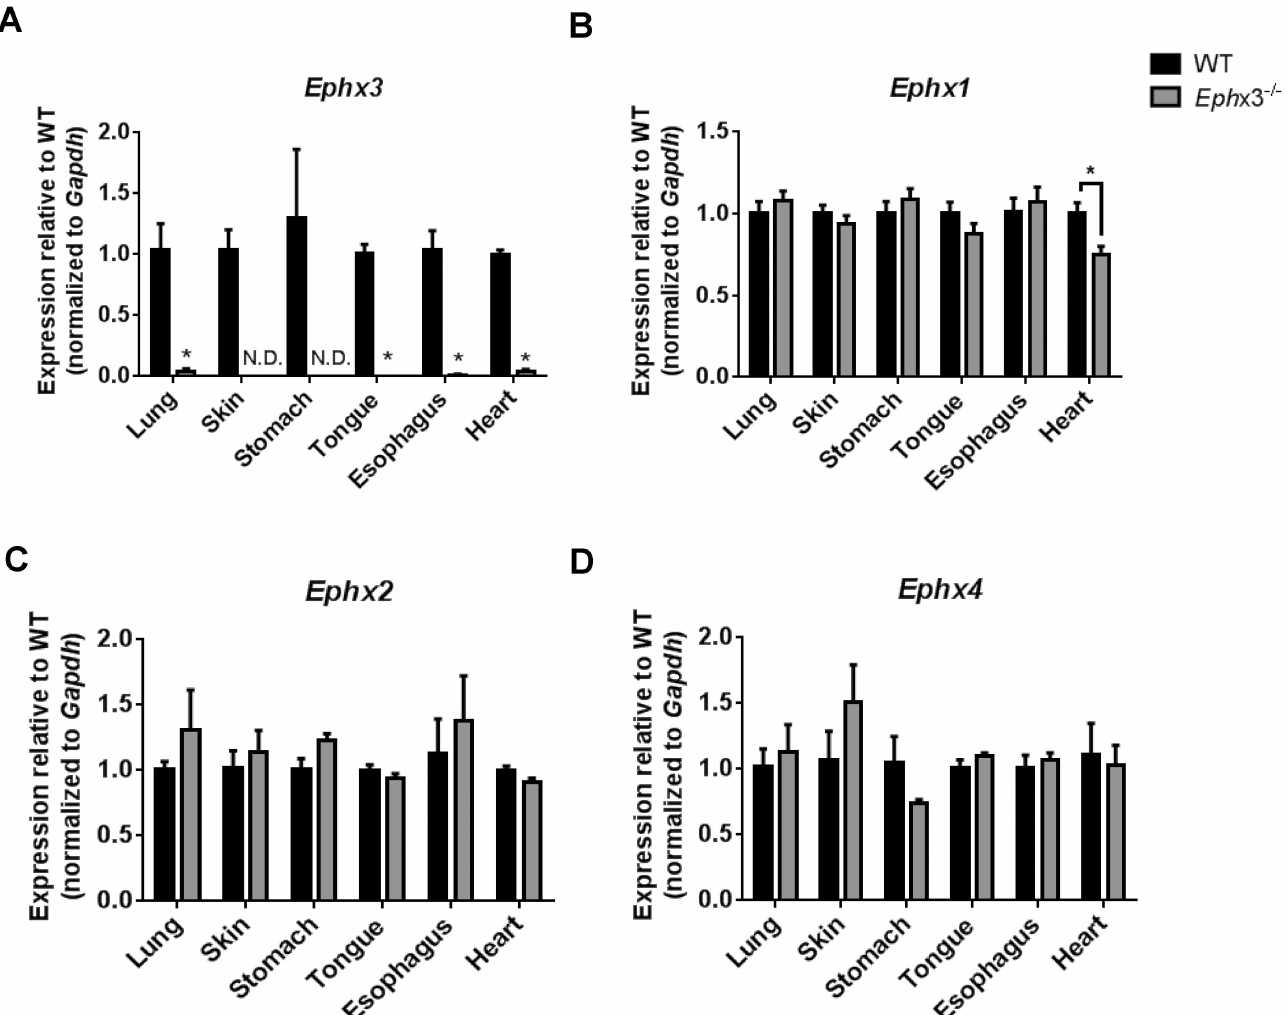
Fig 2. Expression of epoxide hydrolase isoforms in Ephx3 -/- mice. Quantitative RT-PCR of (A) Ephx3 , (B) Ephx1 , (C) Ephx2 , and (D) Ephx4 in Ephx3 -/- and WT mice. ( * p < 0.05;n = 3–4).